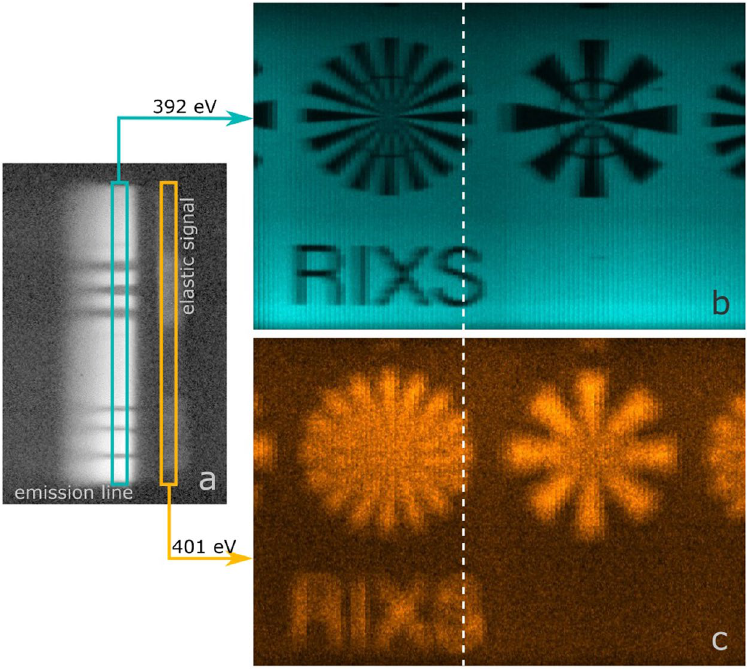
Figure 4. ( a ) RIXS signal of a test sample illuminated with a line focus of 10 μ m(h) × 1000 μ m(v) at a mean incident photon energy of 401 eV ± 0.35% (elastic peak of Si 3 N 4 ) and an exposure time of 20s. ( b ) and ( c ) are reconstructions out of 101 such images, whereby ( b ) is reconstructed from the inelastic Si 3 N 4 X-ray emission signal and ( c ) from the elastic signal. The dashed line in ( b ) and ( c ) indicates the position of the signal ( a ). The sample was a silicon wafer coated with 250 nm Si 3 N 4 and 20 nm thick Au patterns. The diameter of the Siemens star was 500 μ m. In the left star with the finer spokes, the outer ring structure marks structure width of 25 μ m whereas the inner ring marks structure width of 10 μ